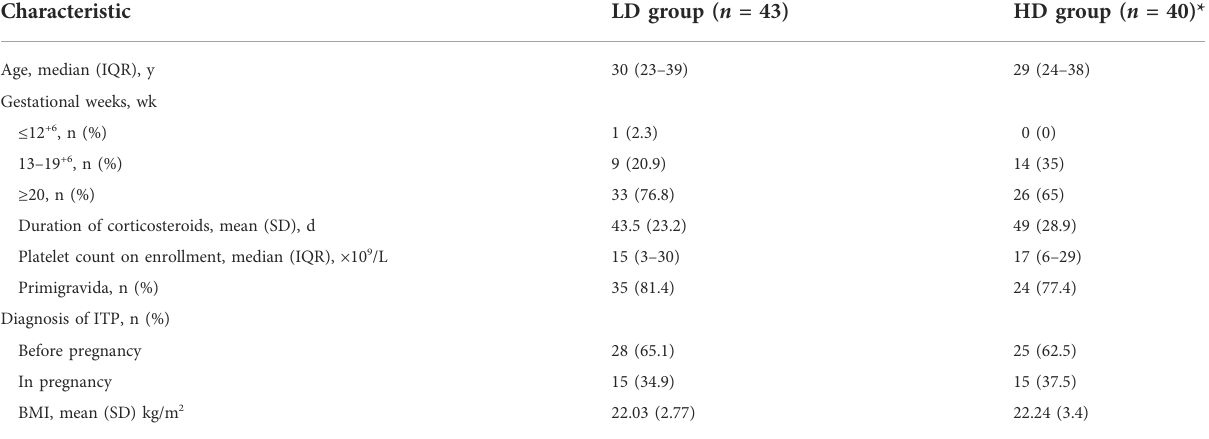
TABLE 1 Baseline characteristics of patients taking prednisone enrolled in the study.